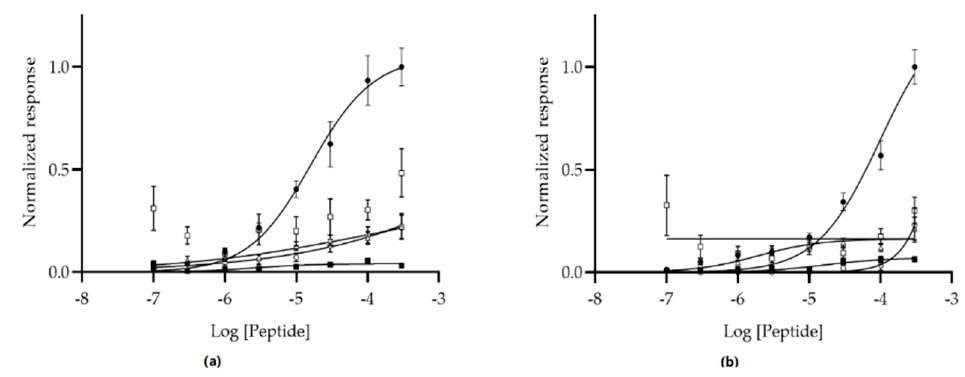
Figure 3. Dose–response study of biotin-GSG-MCA1 and biotin-GSG-MCA2 binding to Mia Paca-2 ( • ), hTERT-HPNE ( (cid:3) ), HEK 293 ( ∆ ), SKOV-3 ( (cid:4) ), and LNCaP ( ◦ ) cell lines. Varying concentrations (0.1–300 µ M) of peptides were added to the cells for 1 h. Peptides were probed with HRP-conjugated streptavidin and binding was measured spectrophotometrically at 405 nm after addition of ABTS (SpectraMax 250 microplate reader, Molecular Devices, San Jose, CA). Dose–response curves were fitted using GraphPad Prism (vs. 8.3.0). ( a ) The EC 50 value for biotin-GSG-MCA1 incubated with Mia Paca-2 cells was 16.11 µ M (CI [9.69, 26.31 µ M]). ( b ) The EC 50 value for biotin-GSG-MCA2 incubated with Mia Paca-2 cells was 97.01 µ M (95% CI [58.64, 166.30 µ M].